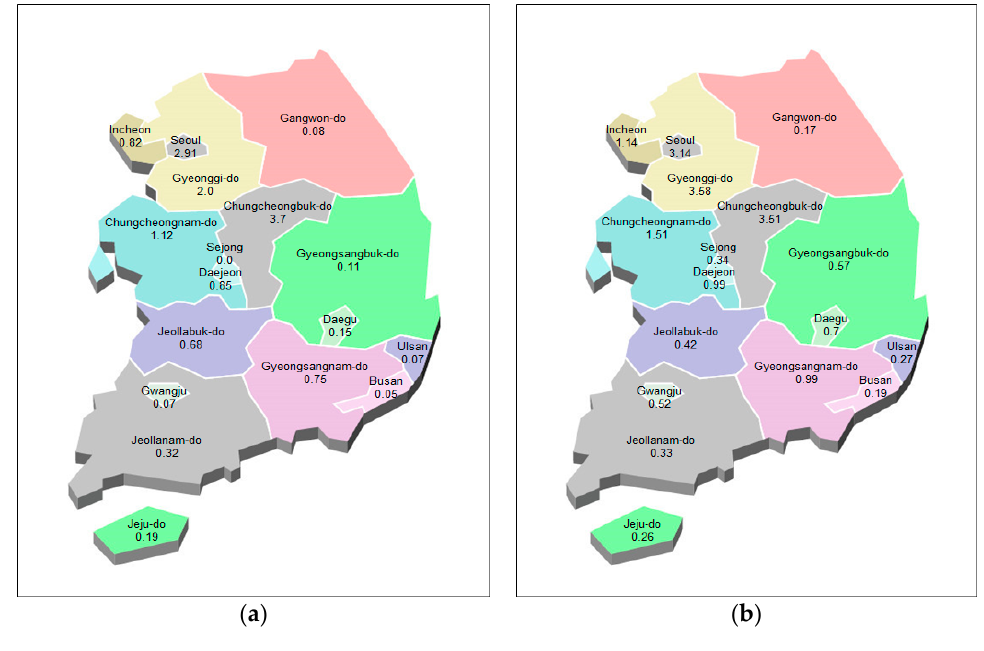
Figure 12. National prediction map of epidemic of hepatitis A. ( a ): actual values, ( b ): predicted values.